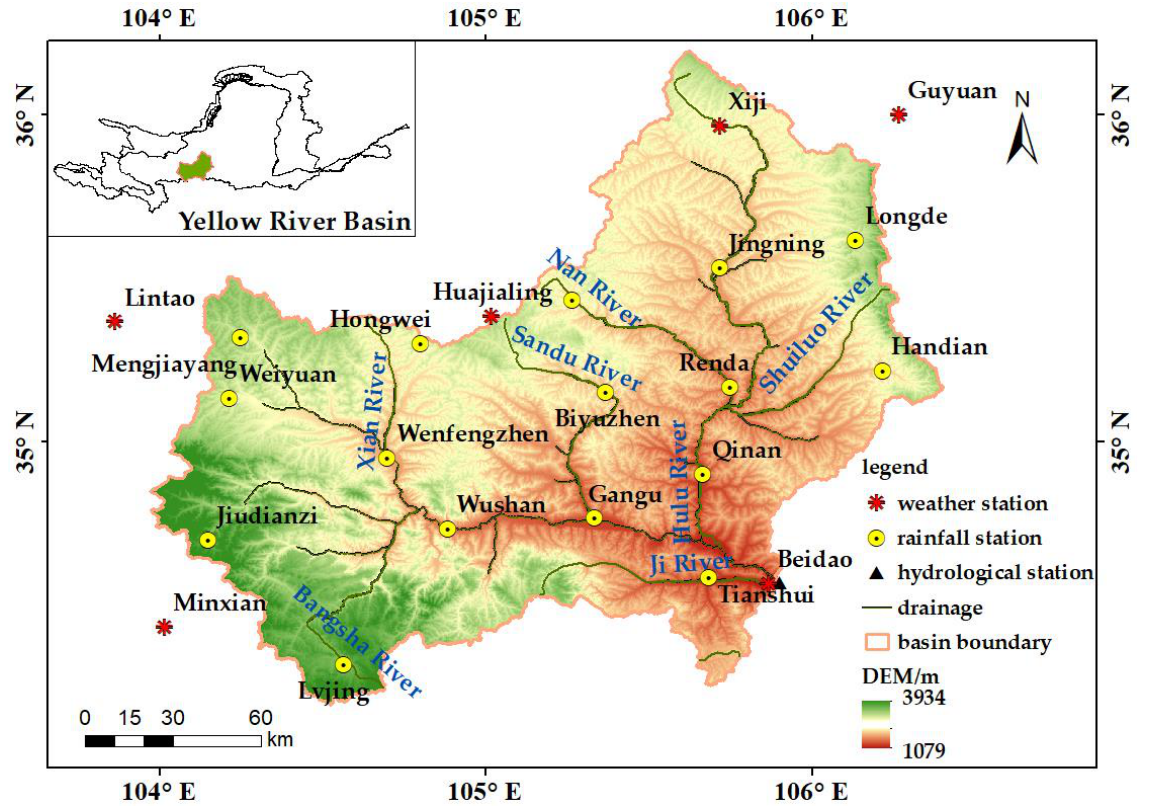
Figure 1. Location of the study area and the stations.